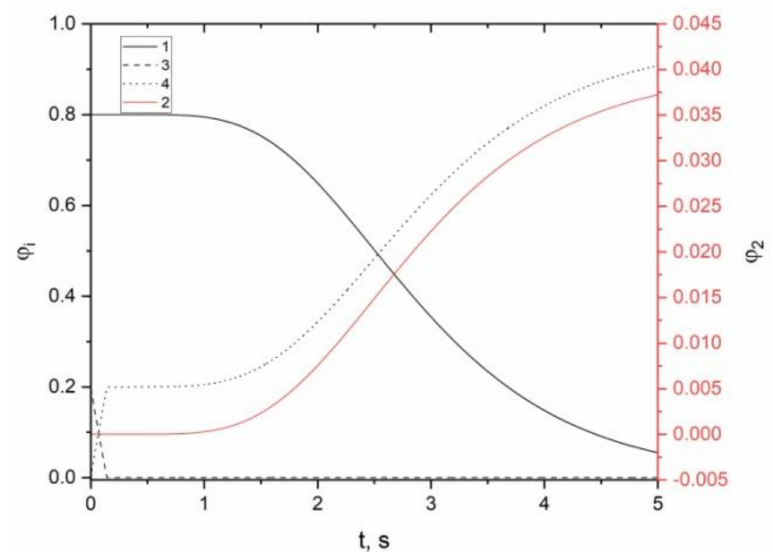
Figure 13. Distribution of volume fractions of phases under the influence of a low-intensity surface forest fire depending on time (summer, July, +20 ◦ C, ϕ 30 = 0.2, α s = 0.05): 1—dry organic matter, 2—soot particles, 3—moisture, 4—gas.